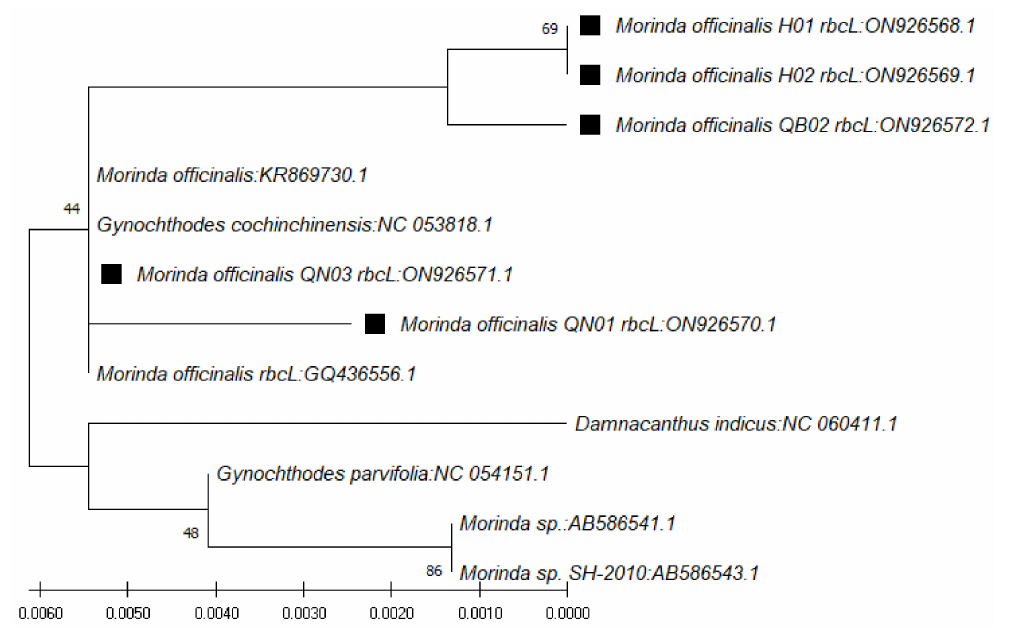
Figure 5. Phylogenetic tree by maximum likelihood of similarity between M. officinalis and the closest species as per rbcL region sequences. The samples of our study are marked by black squares next to their